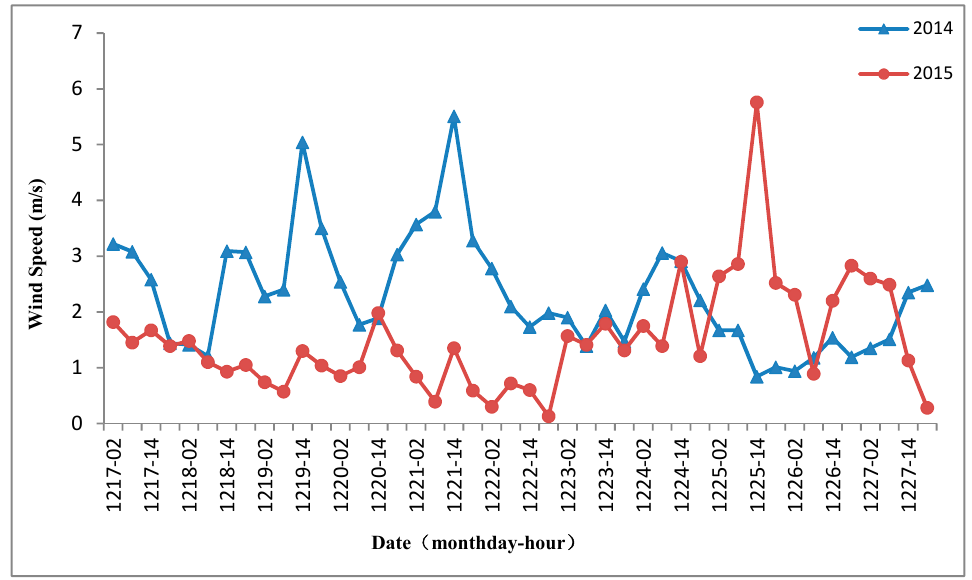
Figure 10. Comparison of wind speed from 17 December to 27 December between 2014 and 2015.